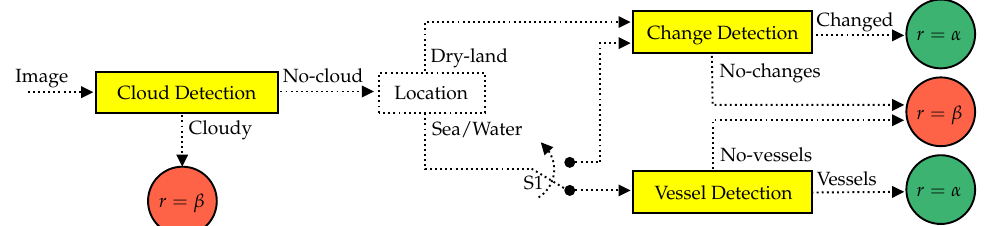
Figure 1. Diagram of the pre-processing step. The image (tile) compression with the coding rate α is represented by the green circles, and the compression with the coding rate β is represented by the red circles. The algorithms for cloud detection, change detection, and vessel detection are illustrated by the yellow